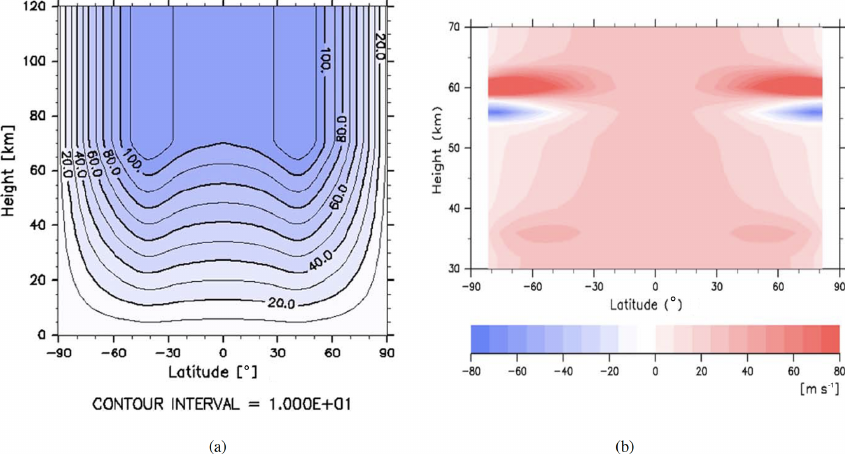
Figure 14. Zonal-mean sections of (a) zonal wind (ms − 1 ) and (b) a∂Q/∂φ (ms − 1 ) typical of Venus’s global circulation, as presented by Sugimoto et al. (2014) from their numerical model